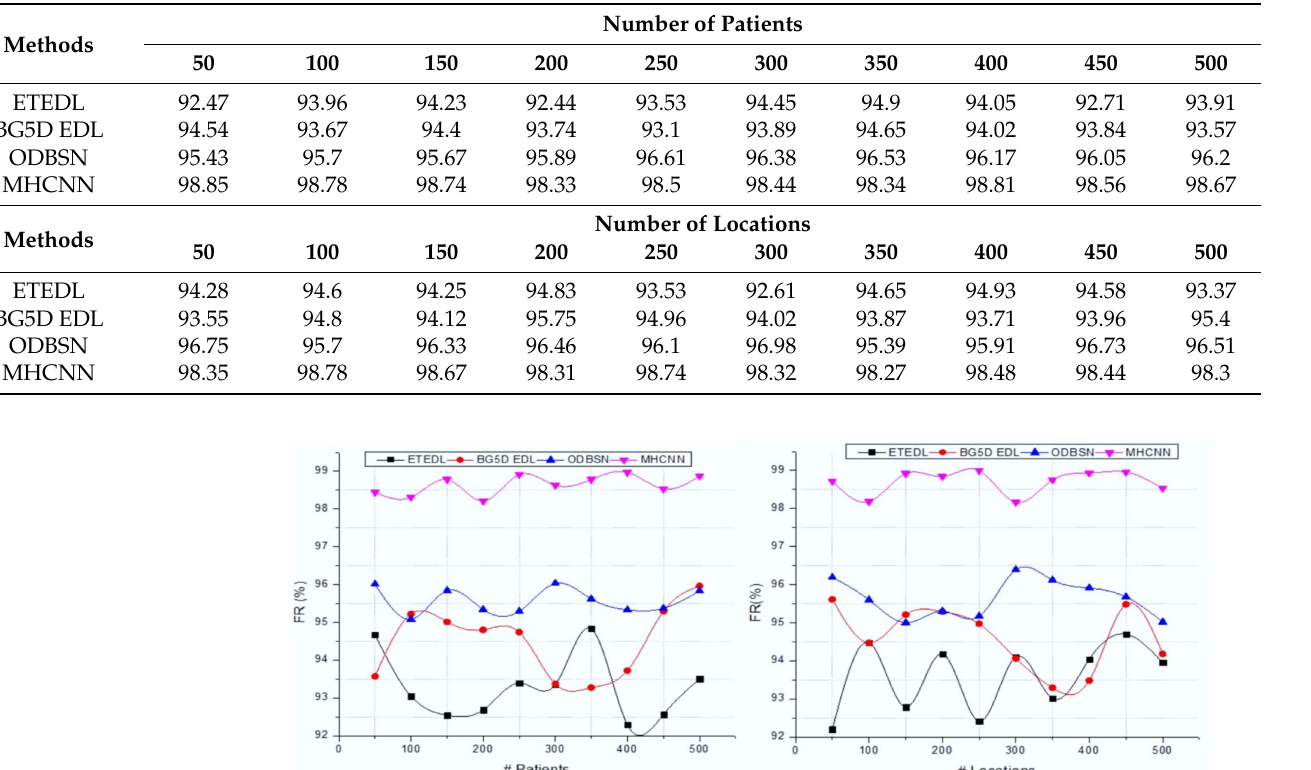
Figure 6. Fit-rate analysis with various numbers of patients and